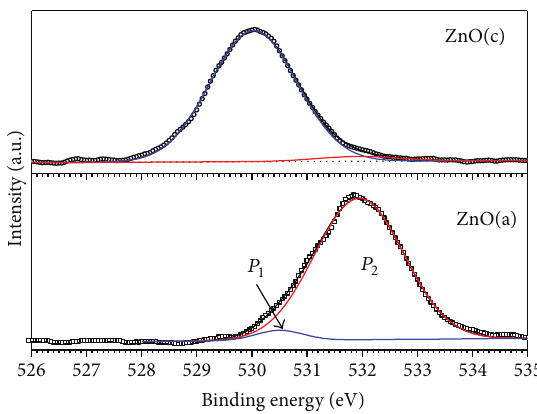
Figure 4: O 1s XPS line obtained from ZnO thin films grown on a-plane and c-plane sapphire.